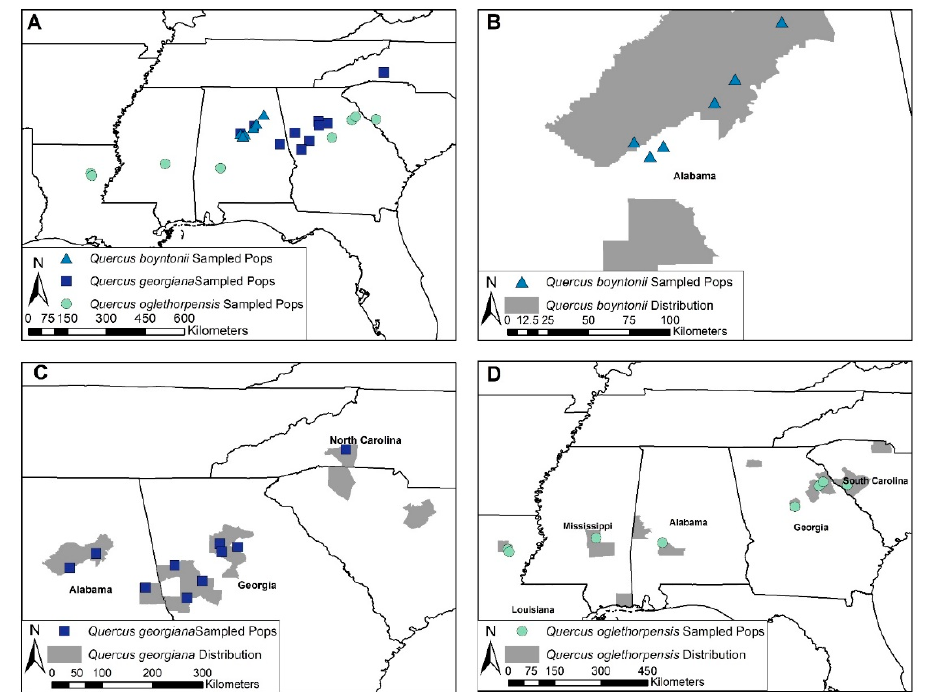
Figure 1. Sampled locations in relation to species geographic range; note that most extant occurrences were sampled. Range is based on county-level occurrences and is derived from USDA PLANTS. Panel ( A ) shows the sampling distribution of all three oak species included in the study; ( B ) depicts the known distribution of Q. boyntonii and sampled locations; ( C ) depicts the known distribution of Q. georgiana and sampled locations; ( D ) depicts the known distribution of Q. oglethropensis and sampled